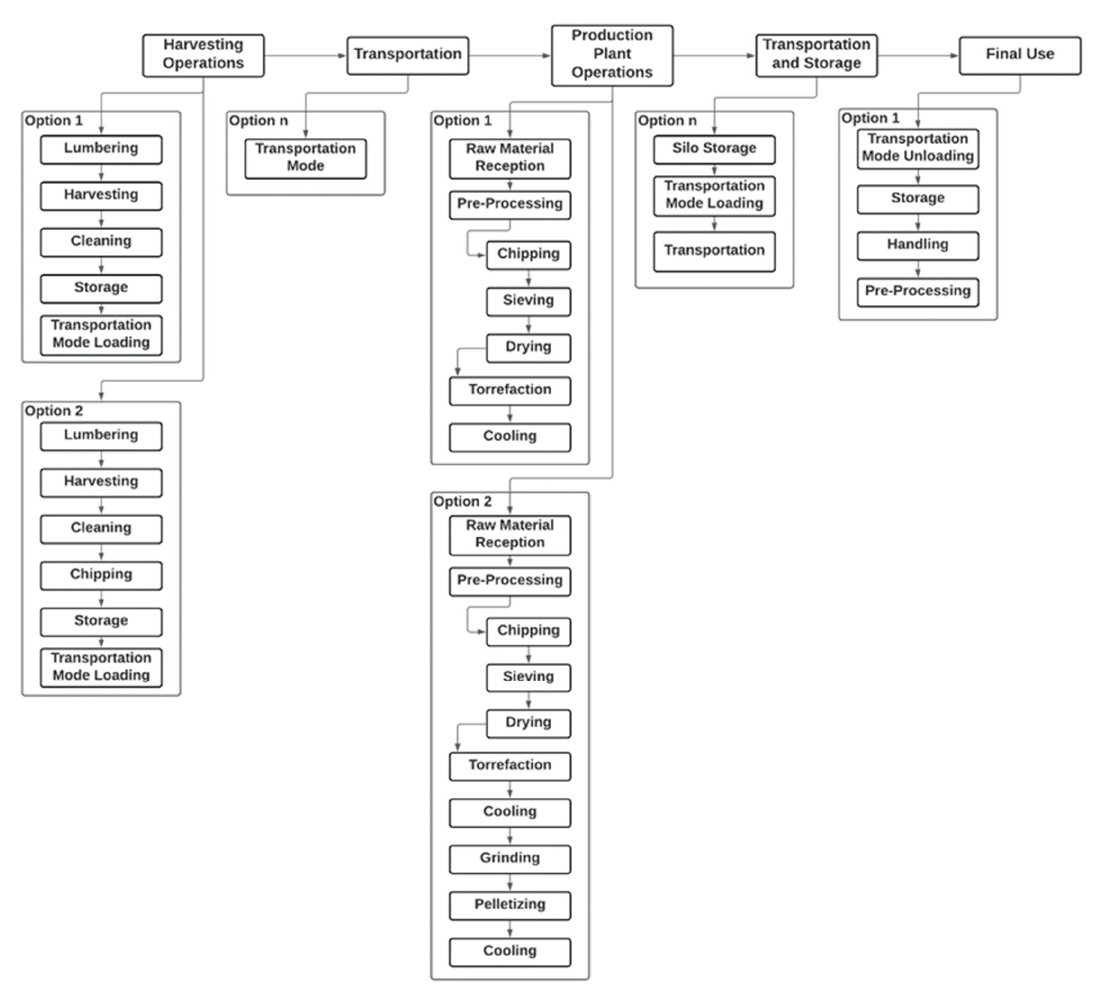
Figure 2. Definition of the different steps and options that may be present in a short distance supply chain.